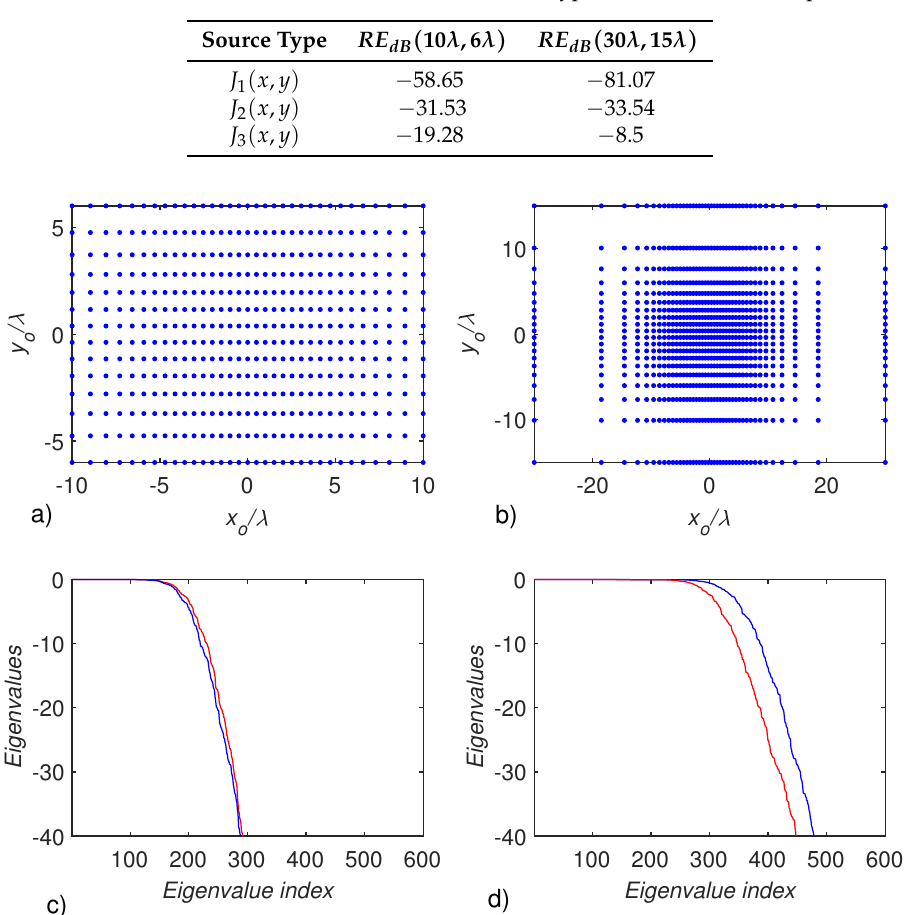
Table 1. Relative error metric ( RE ) for different source types and measurement apertures.